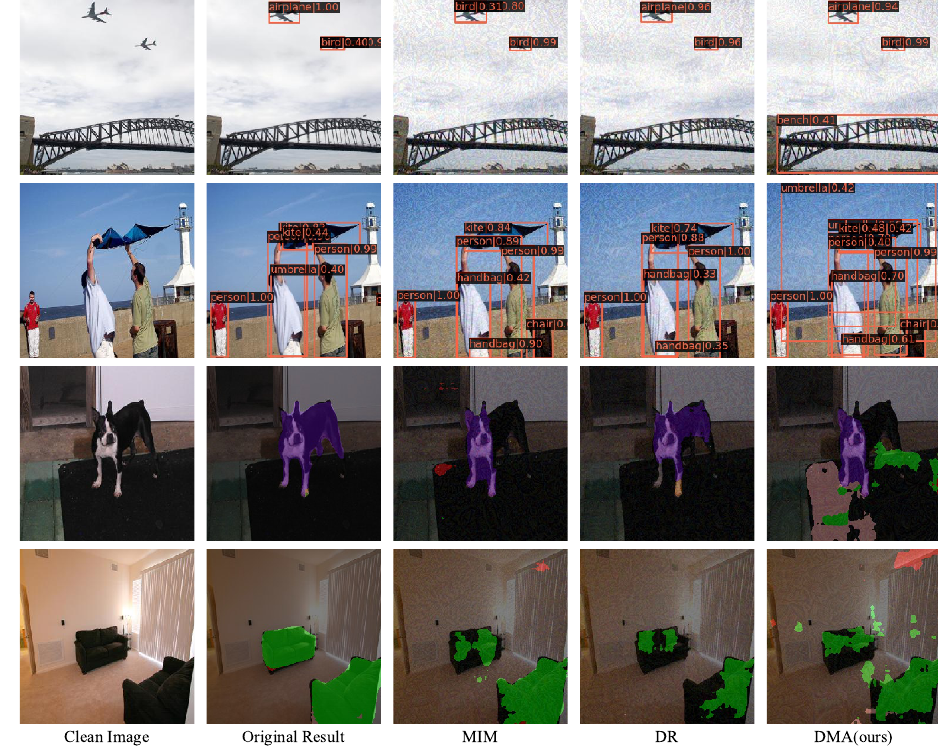
Figure 6. The samples of object detection and semantic